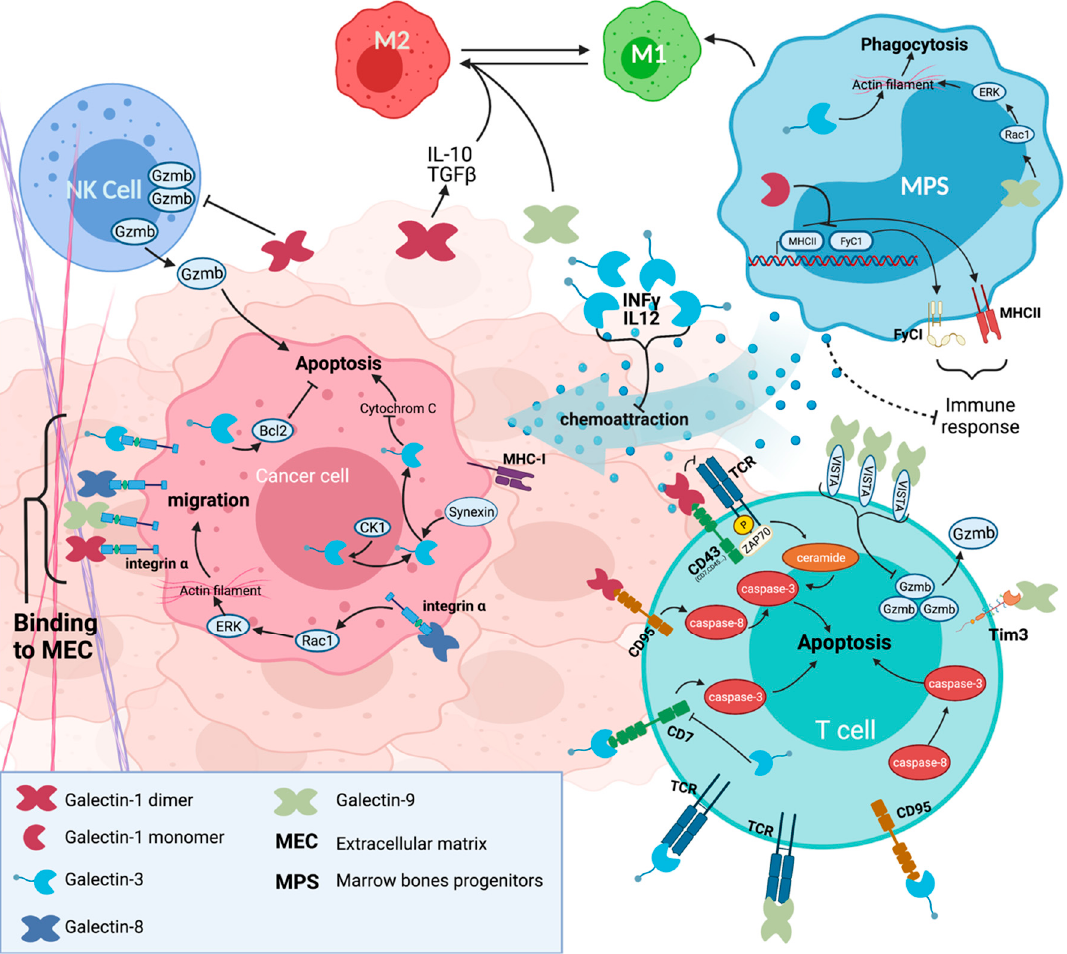
Figure 1. Multiple roles of intra- and extracellular galectins in